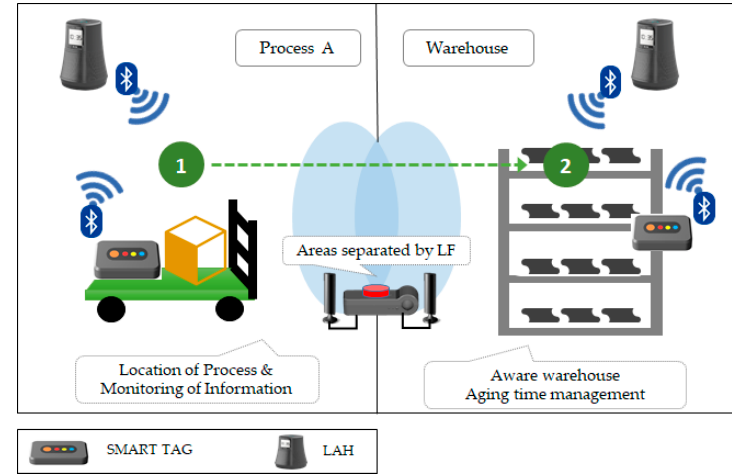
Figure 8. Indoor location awareness and service.